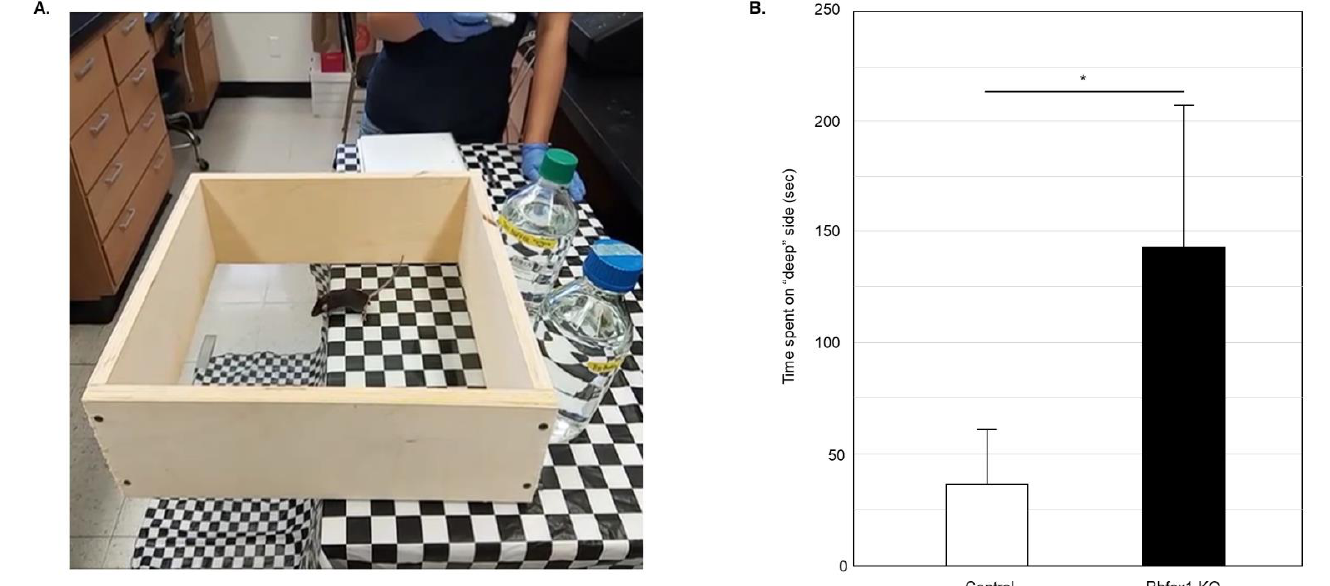
Figure 1. Evaluation of visual function in old Rbfox1 KO mice. ( A ) Visual cliff test setup. A visual cliff illusion was created by placing a glass-bottomed test box on the edge of the table so that one part sits on the table (“shallow” side) and the rest is suspended above the floor (“deep” side). The table and the floor under the test box were covered with black and white checkered table cloth. Animals tested for 5 min and time the spent on the “shallow” and “deep” sides was recorded. Each animal was tested 5 times. ( B ) Control mice spent most of their time on the “shallow” side of the field. The time they spent on the “deep” side was only 36.60 +/− 25.34 s (mean +/ − SD; n = 5) out of 5 min of testing time. Rbfox1 KO mice showed no preference to either side of the test field. The time the Rbfox1 KO animals spent on the “deep” side was 141.75 +/− 64.63 s (mean +/ − SD; n = 5). The mean difference in time spent on the “deep” side between two groups was statistically significant: 105.15 s (* p = 4.55×10 − 7 ).